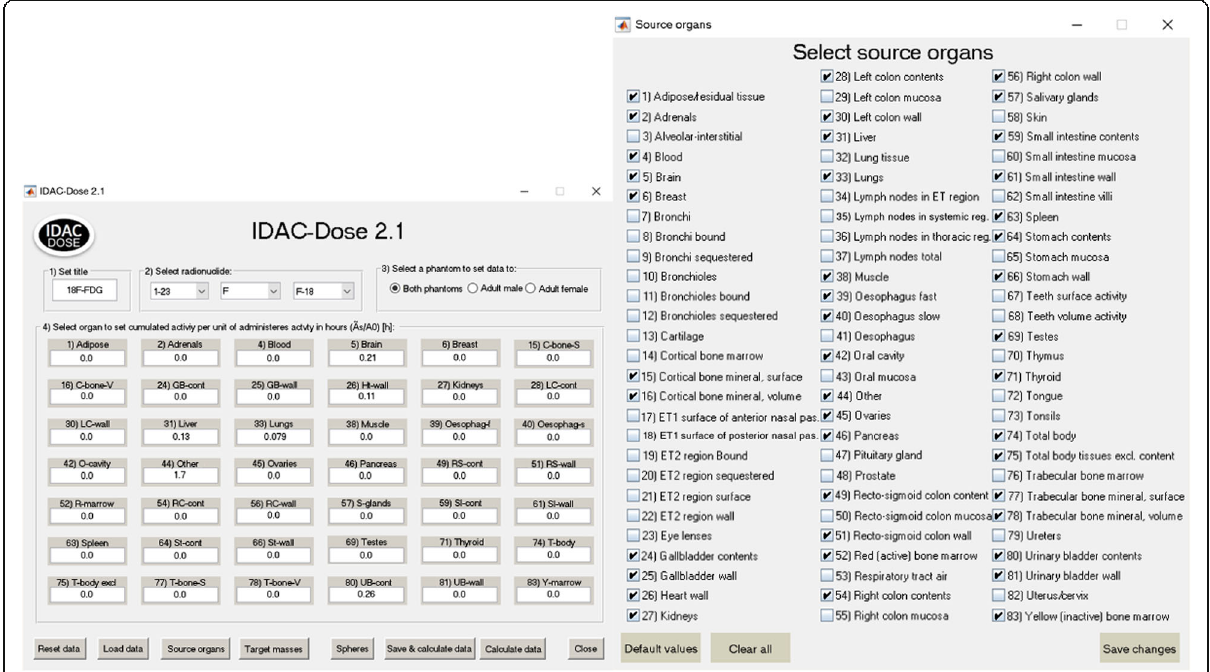
Fig. 1 Example of the IDAC-Dose2.1 interface. Left, radionuclide 18 F has been selected as an example and the cumulated activity per administered activity given in hours from the biokinetic model of 18 F-FDG in ICRP Publication 128 [9]. Right, the list of all source regions that can be selected in the